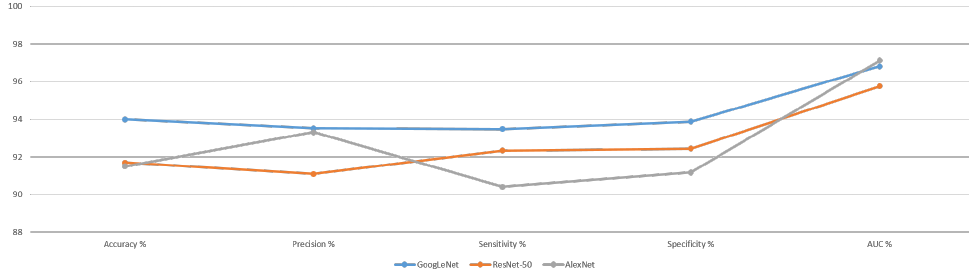
Figure 7. Performance of CNN models for diagnosing the hemorrhage dataset.